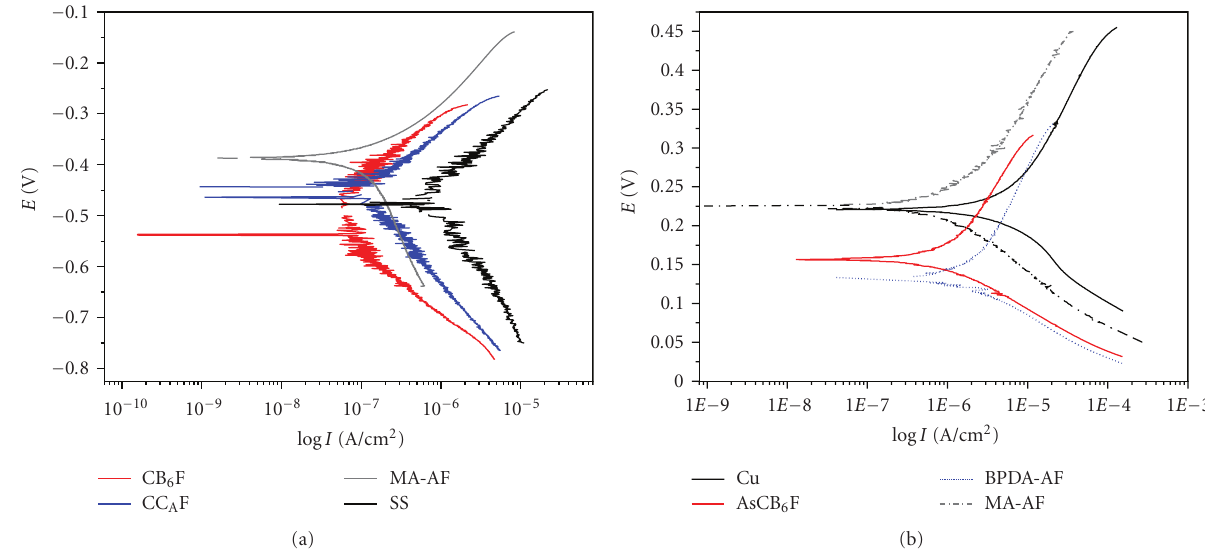
Figure 1: Polarization curves of bare and resins coated SS (a) in copper; (b) in 1 N H 2 SO 4 .